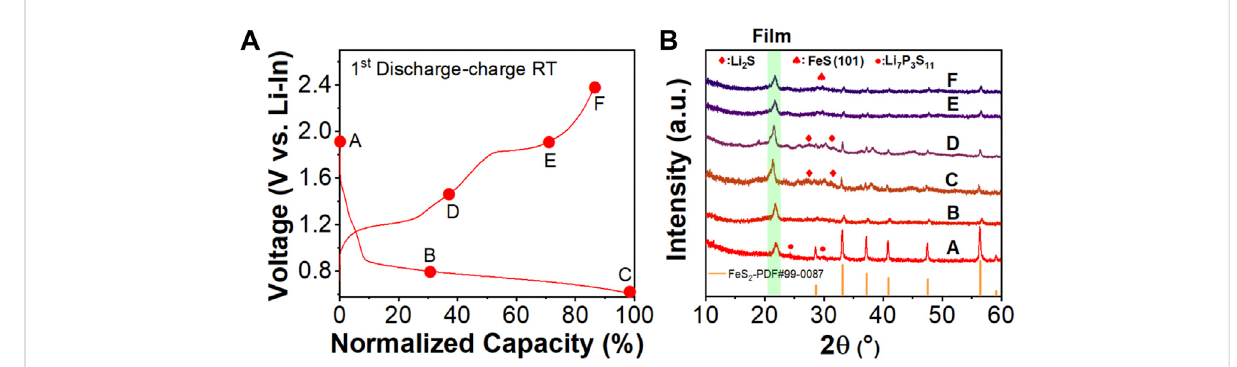
FIGURE 3 (A) The fi rstdischarge/chargecurveswhencycledatroomtemperaturewithnormalizedcapacity.ThemarkedA-Farecorrespondingtovarious charging/discharging states atdifferentcut-off voltages during cycling. (B) The ex-situ XRD patternsof thecycled cathodemixtures atdifferentcut- off voltage from A to F. The orange vertical bar represents PDF #99-0087